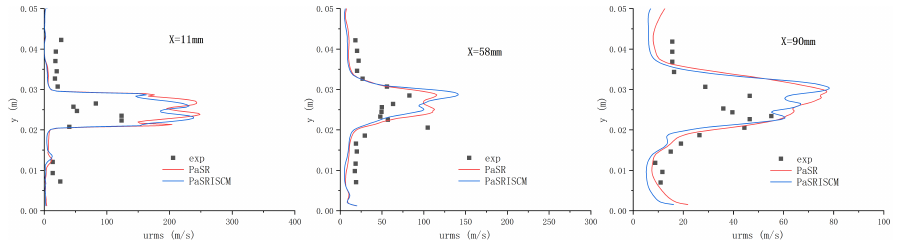
Figure 17. Velocity rms fluctuation profiles compared with experimental results at three locations using different combustion models.